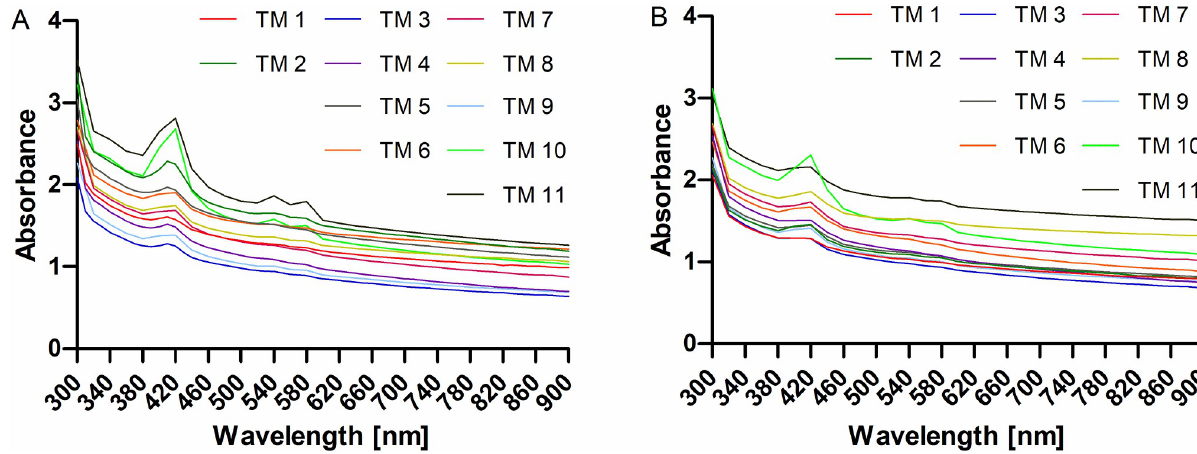
Fig 5. Comparison of spectral scan (A) and area scan (B) of 11 TM from 300 nm to 900 nm.